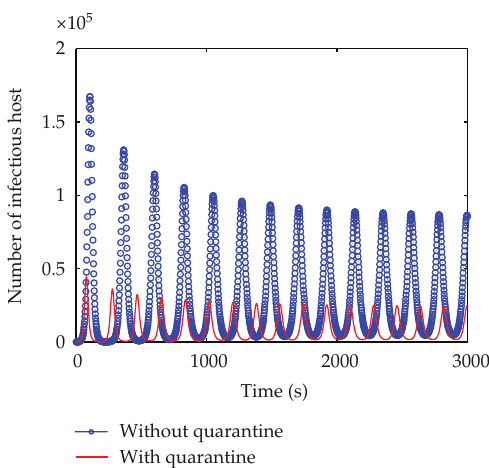
Figure 5: Comparison of infectious hosts before and after adopting quarantine strategy if τ > τ 0